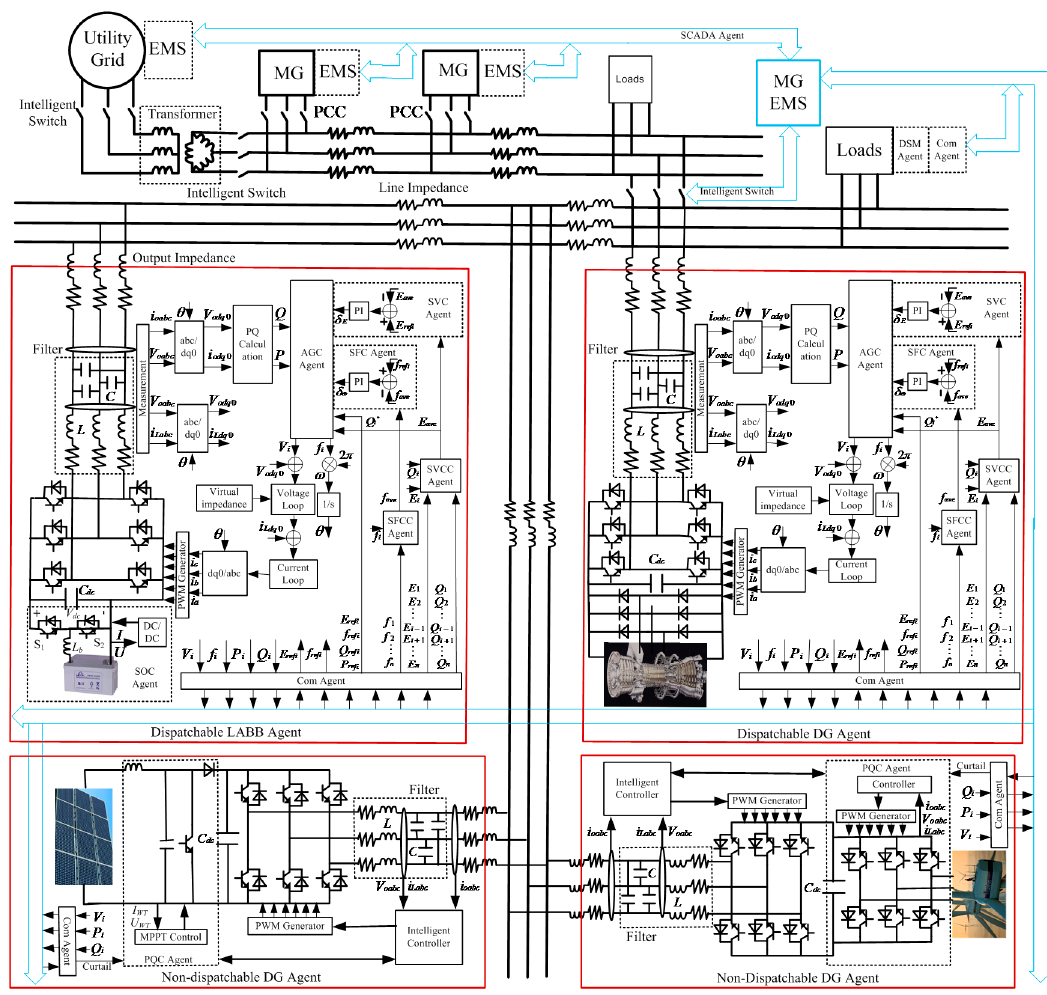
Figure 3. Smart MG voltage source inverter (VSI) based bottom level control structure.